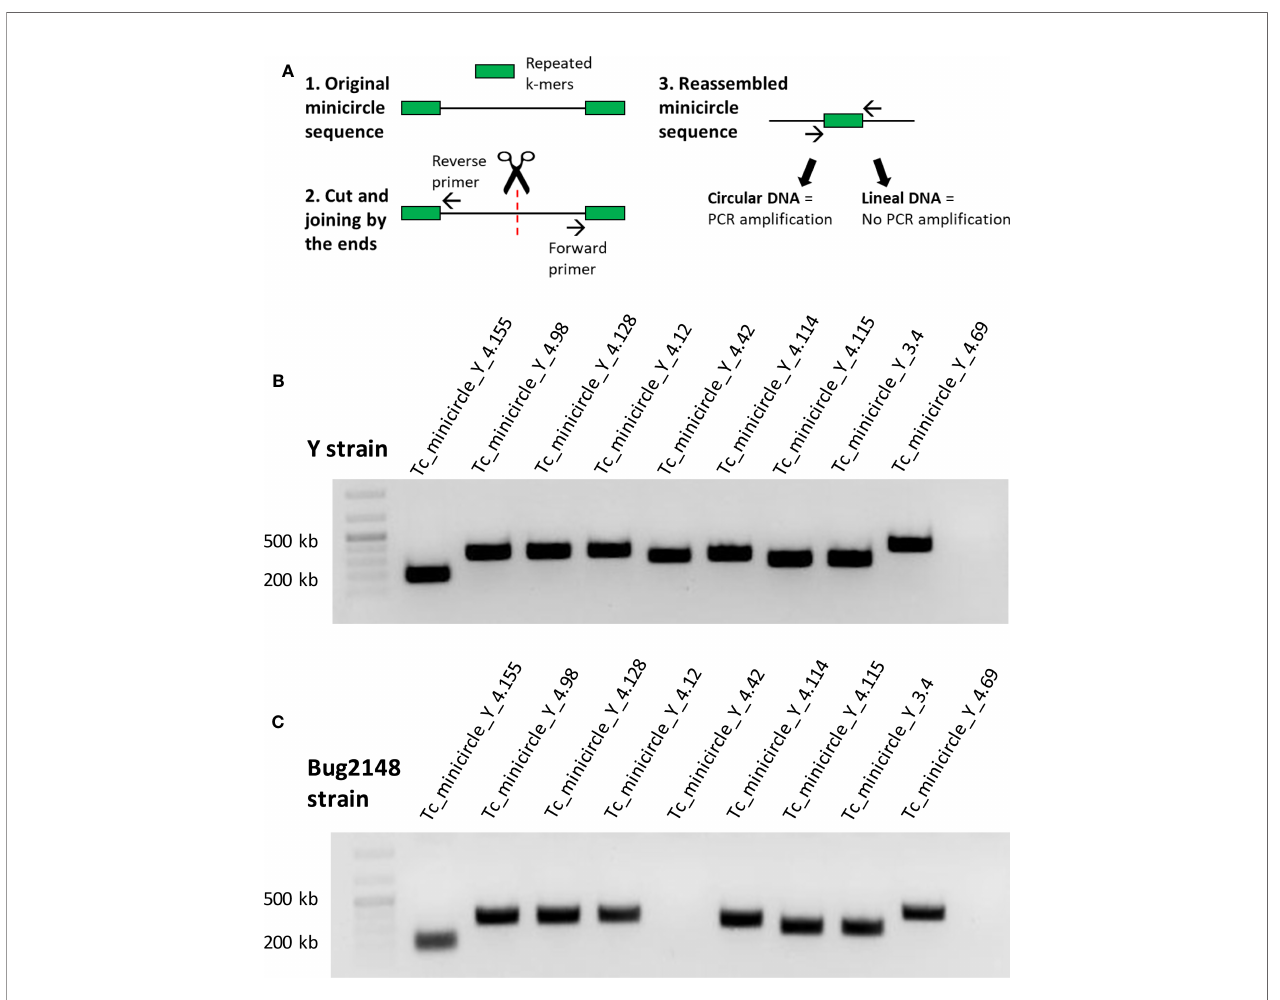
FIGURE 2 | (A) Strategy followed to con fi rm sequence and circularity of the Y strain minicircles. (B) PCR products of nine minicircles of the Y strain. (C) PCR products with the primers designed against the Y strain, tested in Bug2148